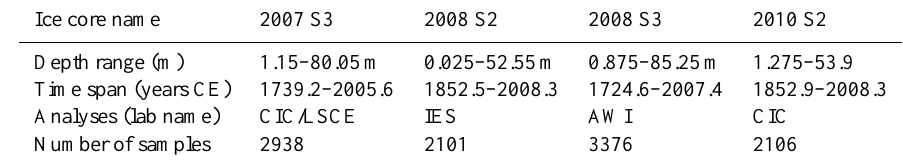
Table 1. NEEM shallow ice core data: name of the core, depth range (upper to lower depth), time span (start and end years) and laboratory where analyses were performed. Note that the δD measurements of 2007 S3 were performed at LSCE only down to 19.65m (year